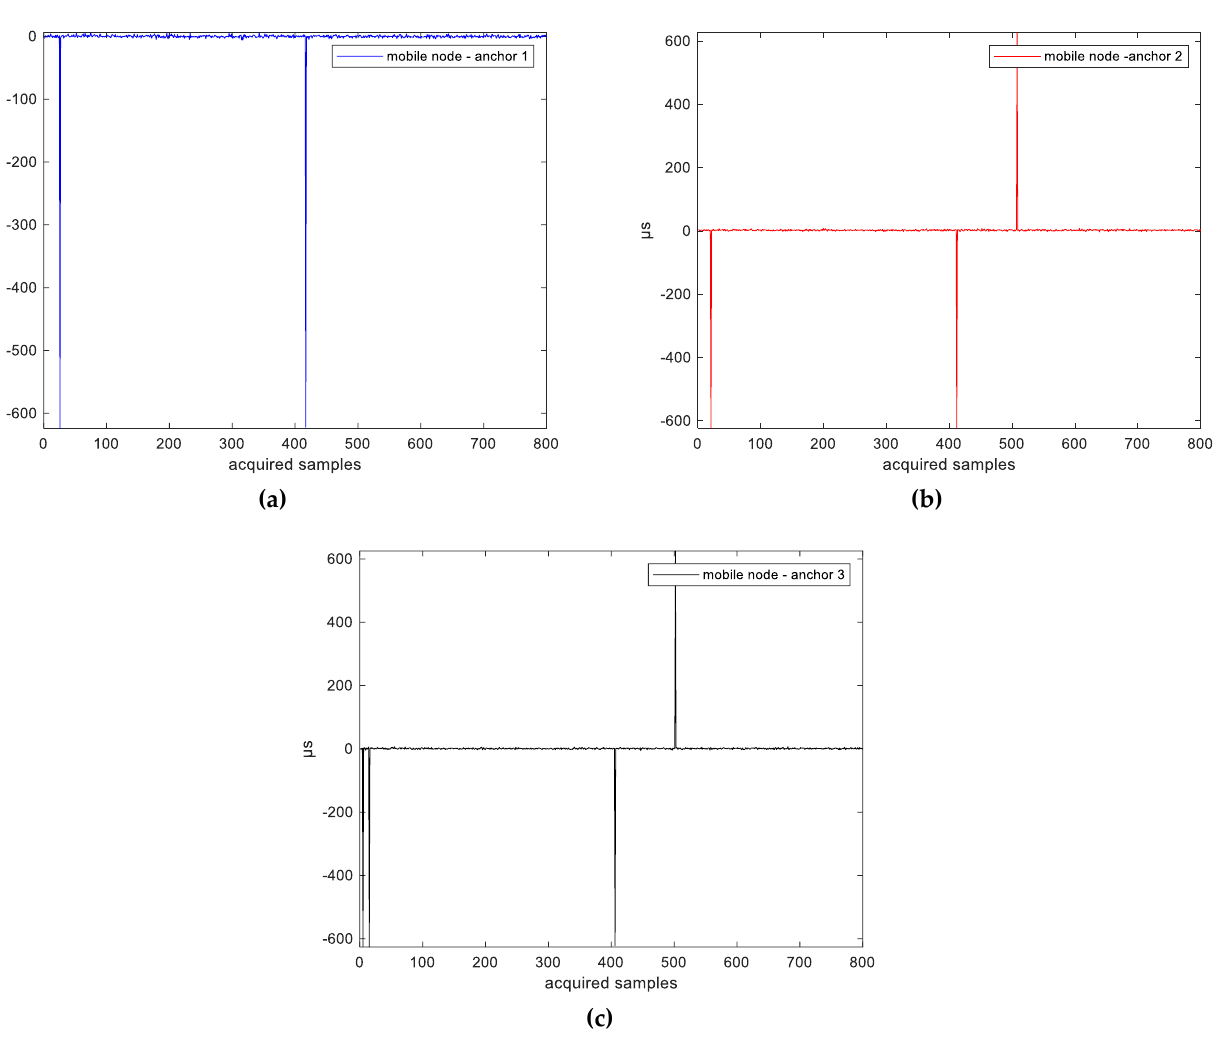
Figure 2. ( a – c ) show the time-synchronization delay waveforms between each considered couple of nodes.